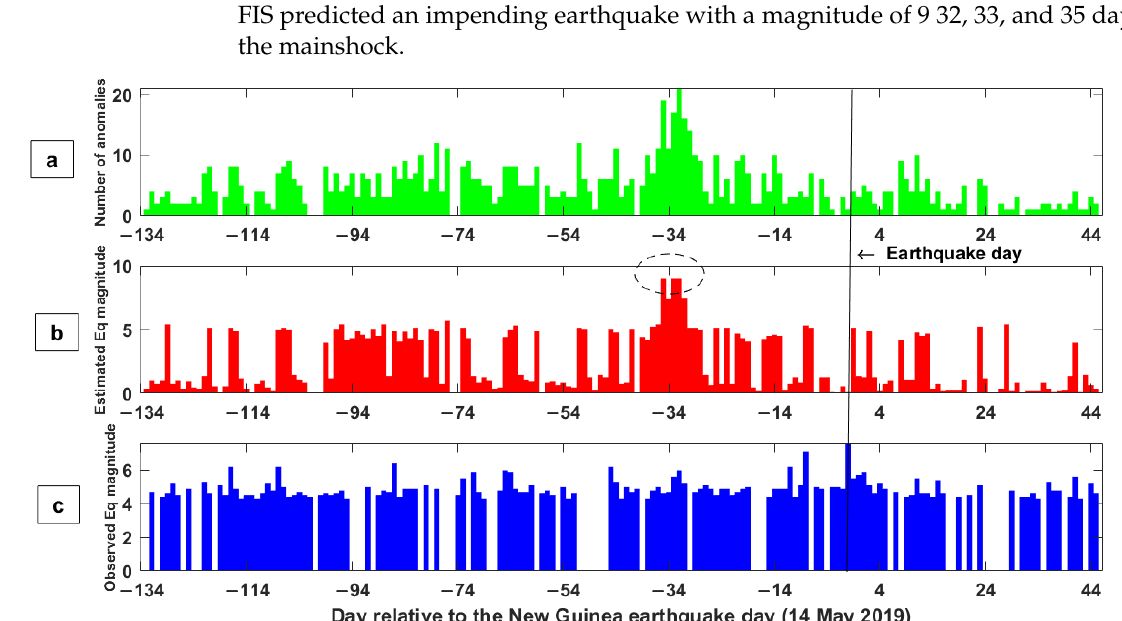
Figure 8. ( a ) Variation in the number of anomalies (green curve), ( b ) variation in the predicted earthquake magnitude (red curve), and ( c ) variation in the observed earthquake magnitude (blue curve) for the Papua New Guinea earthquake (14 May 2019) from 1 January to 30 June 2019. In both panels, the x -axis represents the day relative to the earthquake day, indicated as a vertical dotted